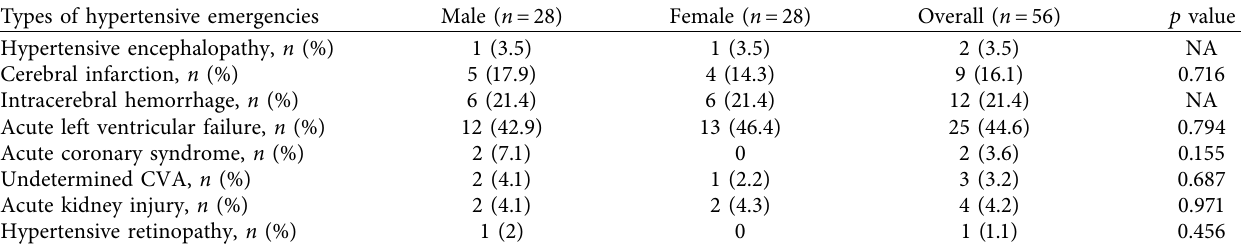
Table 3: Types of hypertensive